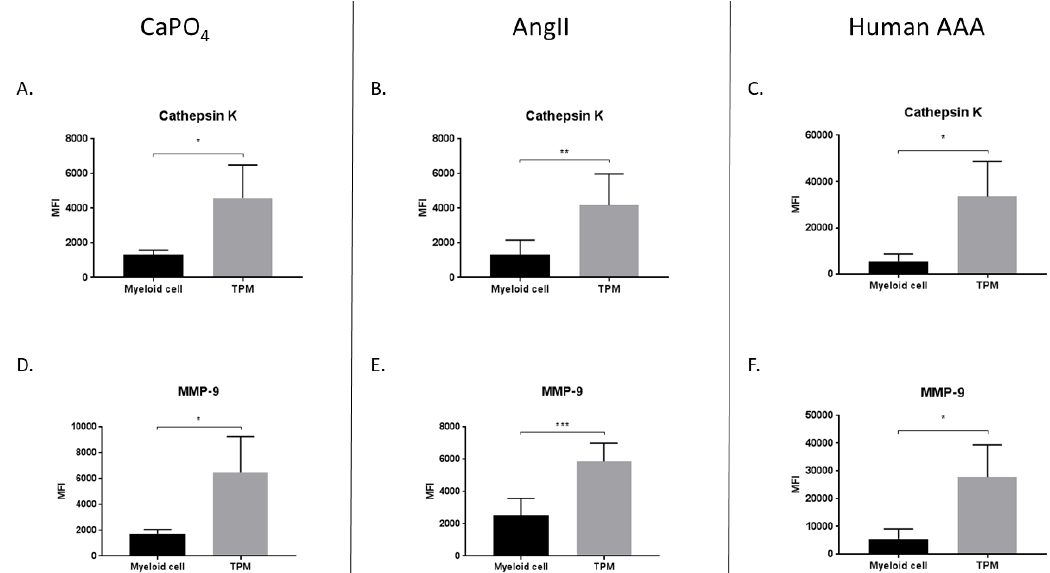
Figure 7. TRAP-positive macrophages produce more proteases than myeloid cells in mouse CaPO 4 ( A , D ), mouse AngII ( B , E ), and human ( C , F ) aneurysms. Aneurysmal tissues from CaPO 4 -treated mice ( n = 4), AngII-treated mice ( n = 6), and human AAA ( n = 4) were enzymatically digested and processed to obtain single-cell suspensions for flow cytometric analysis, as described in the Methods section. The expression of cathepsin K ( A – C ) and MMP-9 ( D – F ) is compared between myeloid cells (CD11b + , TRAP − ) and TPMs (CD11b + , TRAP + ). Data are expressed as mean ± SEM. * p < 0.05, ** p < 0.01, *** p < 0.001. TPM, TRAP-positive macrophage. AAA, abdominal aortic aneurysm.